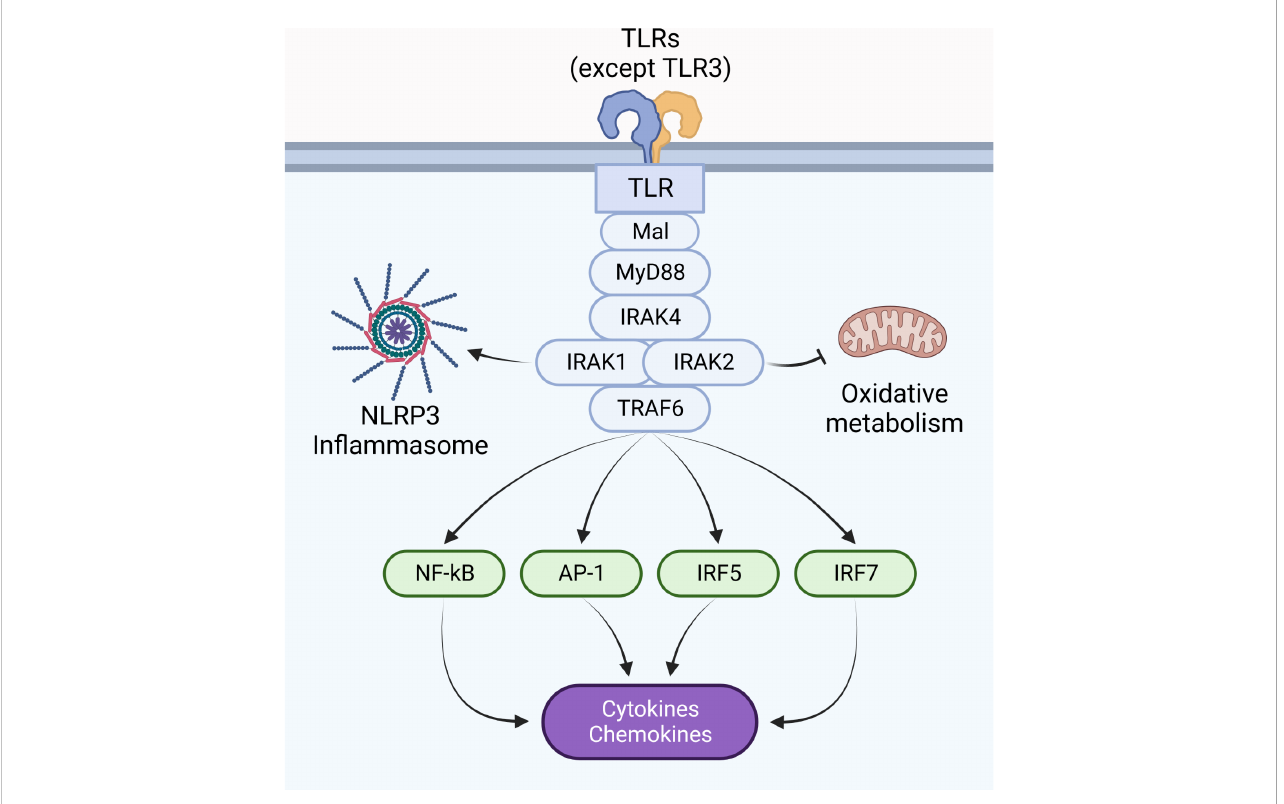
FIGURE 1 Pro-in fl ammatory responses are coordinated by the myddosome. The myddosome is a supramolecular signaling complex assembled upon dimerization of IL-1Rs and most TLRs (except TLR3), and is composed of MyD88, IRAK4, IRAK1 and/or IRAK2, in addition to TRAF6. Its activity coordinates the in fl ammatory response by activating NLRs, modulating metabolic responses, and regulating gene transcription via activation of transcription factors such as NF- k B, AP-1, IRF5, and